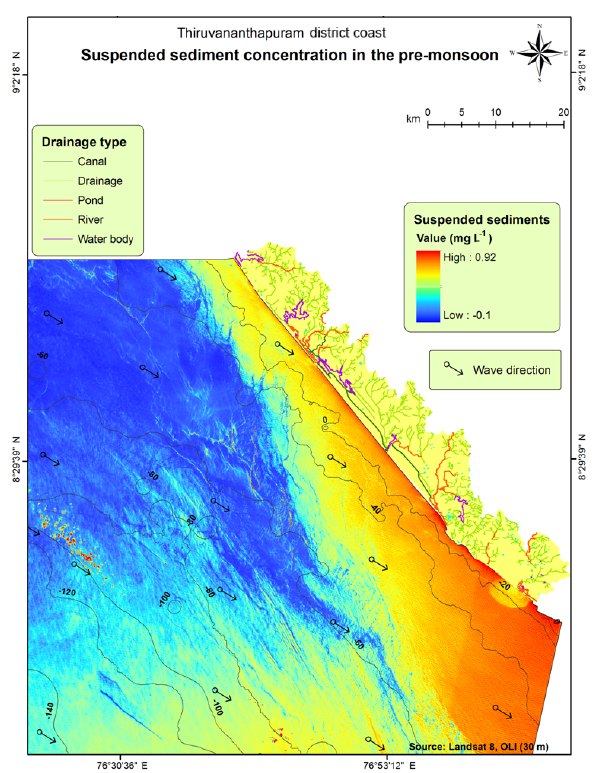
Figure 4. Suspended sediments in the pre-monsoon period.